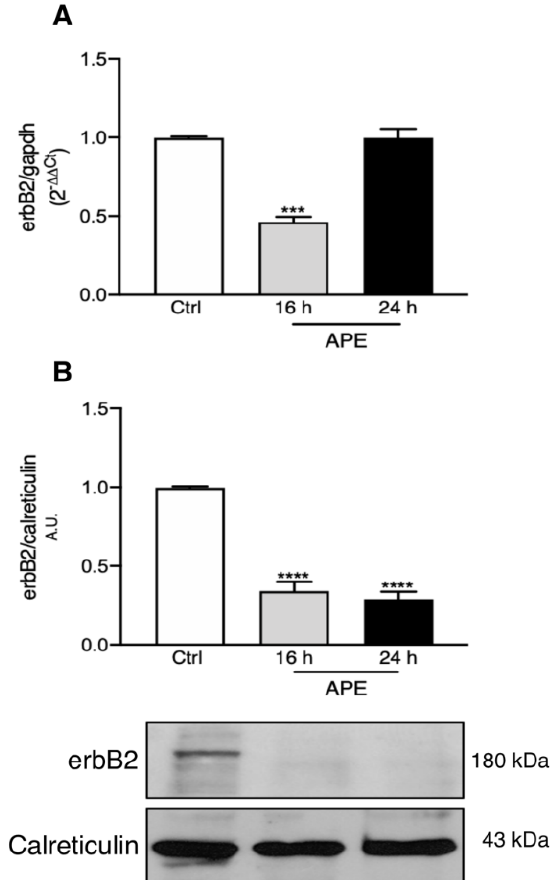
Figure 3. ErbB2 expression is modulated by M2 agonist APE. ( A ) qRT-PCR analysis shows the decreased expression of erbB2 receptor transcripts after 16 h of APE treatment (APE 16 h: *** p < 0.001; n = 3); ( B ) Representative Western blotting showing the decreased expression of erbB2 receptor after 16 and 24 h of APE treatment; the graph represents the average of the OD ± SEM of the bands normalized against the reference protein (**** p < 0.0001; n = 3). Calreticulin was used as reference protein considering the prevalent accumulation of erbB2 receptors in endoplasmic reticulum (ER) after APE treatment.